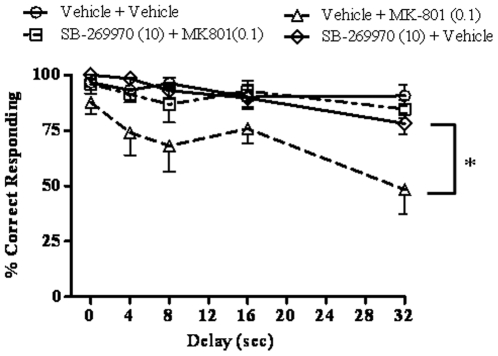
Effects of SB-269970 on MK-801-induced DNMTP deficits.SB-269970 (10 mg/kg) and MK-801 (0.1 mg/kg), or their vehicles, were co-administered 10 min before the beginning of the session (N = 6 per group). SB-269970 had no effect on its own but reversed the deficit caused by MK-801 (*p<0.05, main effect). For statistical details see the result section.